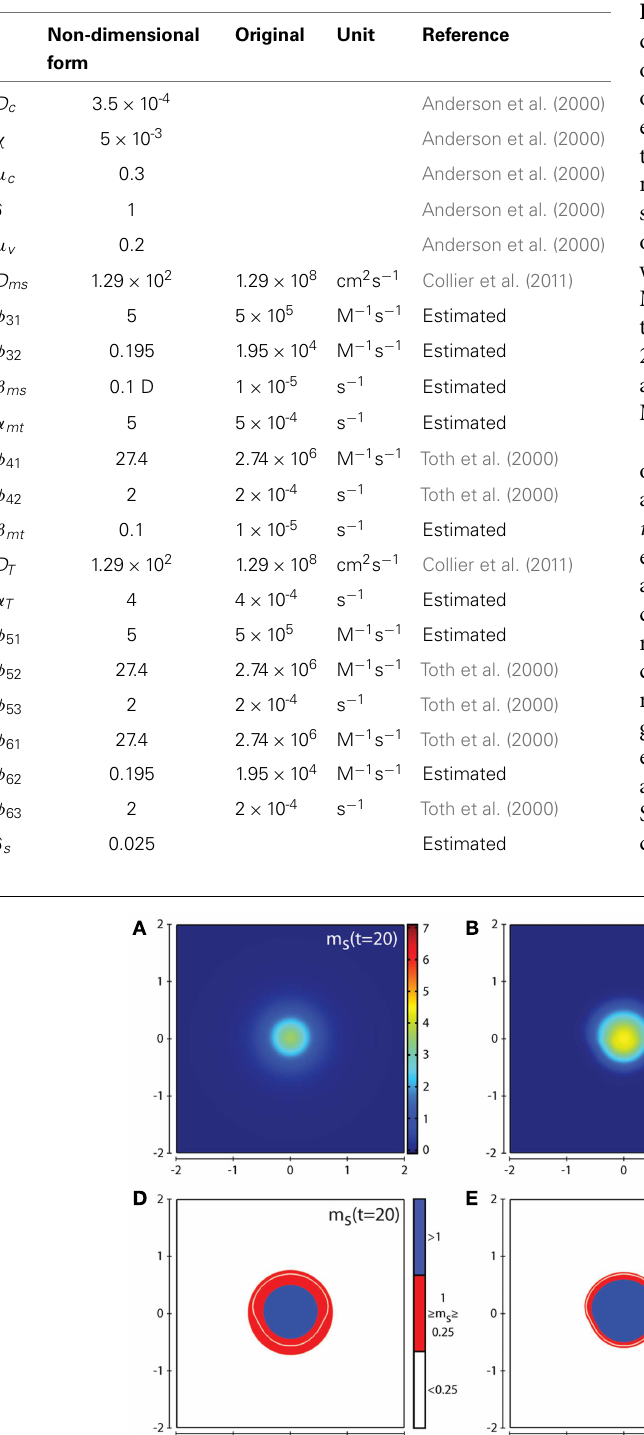
Table 1 | Baseline parameter set for the model.